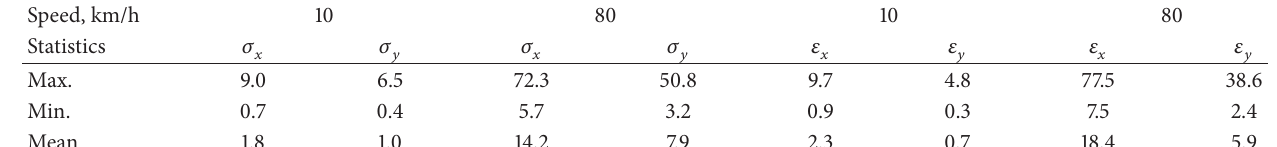
Table 3: Range of computed frequencies (Hz) assuming two different speeds.